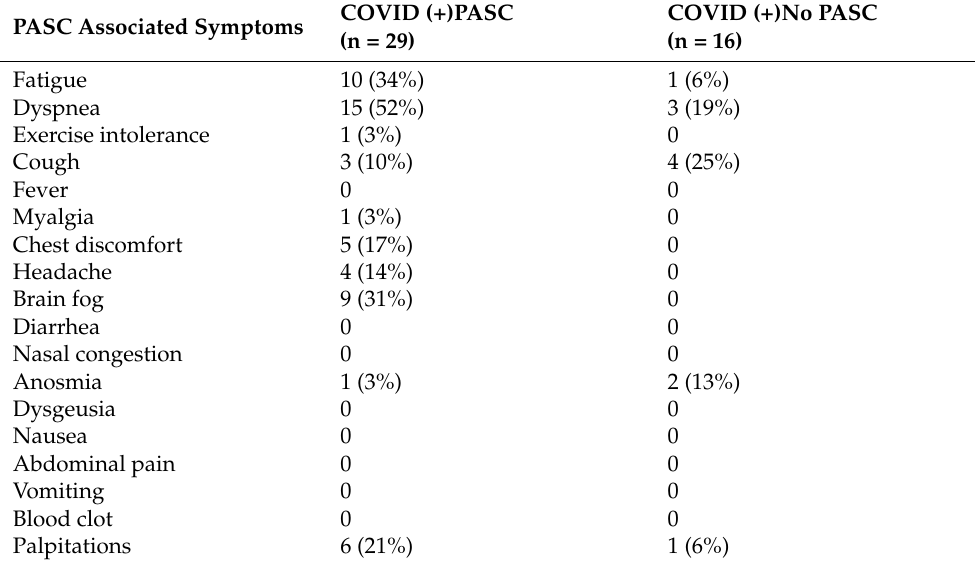
Table 2. Symptoms Assessed